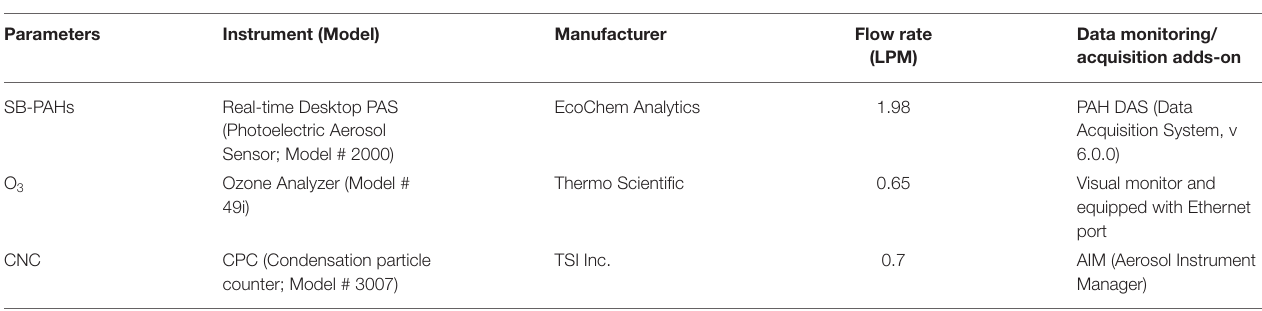
TABLE 1 | Specific details of the instruments deployed in this